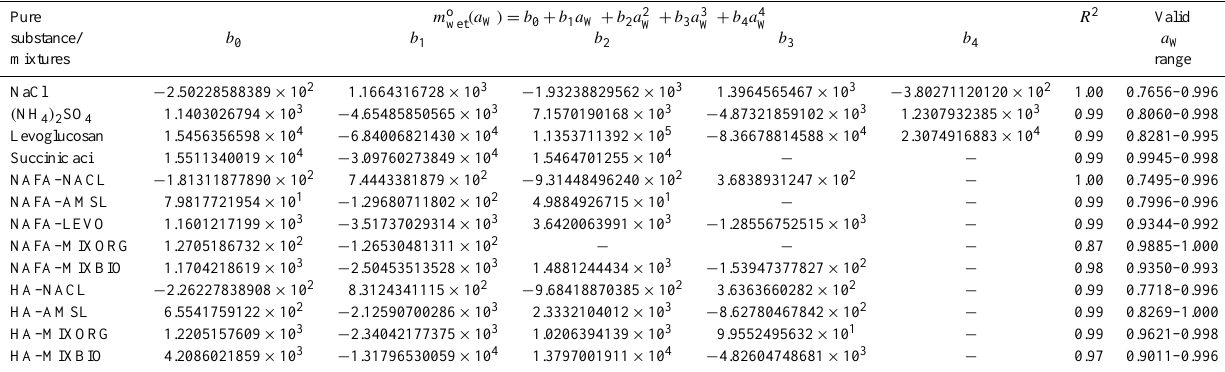
Table 1. Water activity parameterization of data at 25 ◦ C, presented as molality ( m o wet ) versus water activity ( a W ). Every coefficient ( b i ) reported in the parameterization, along with all its decimals, should be used in calculations. Note that molar weight estimates for the humic substances (Fig. 1) were used to calculate the molality of their mixtures.